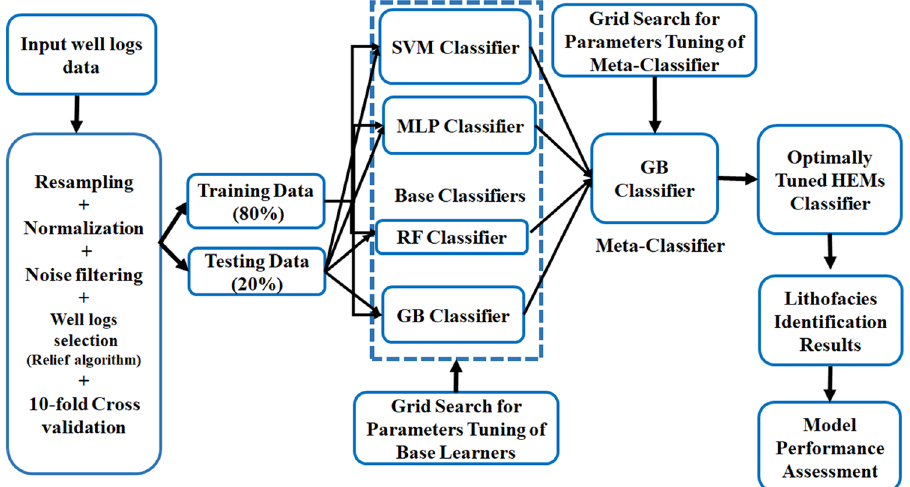
Fig. 4 A generalized concep- tual workflow for the HEMs to recognize the